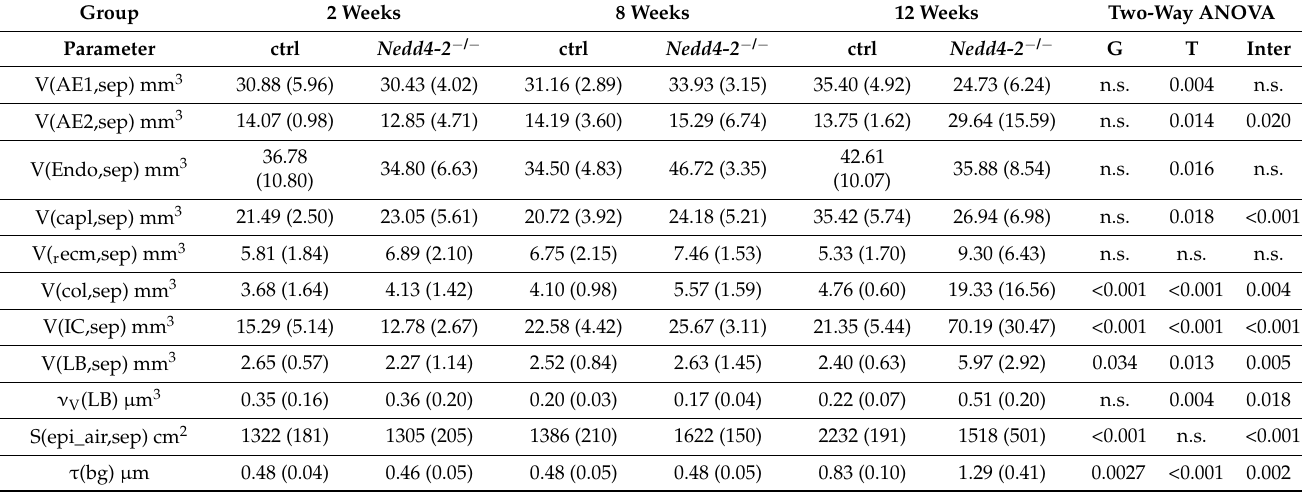
Table 2. Composition of interalveolar